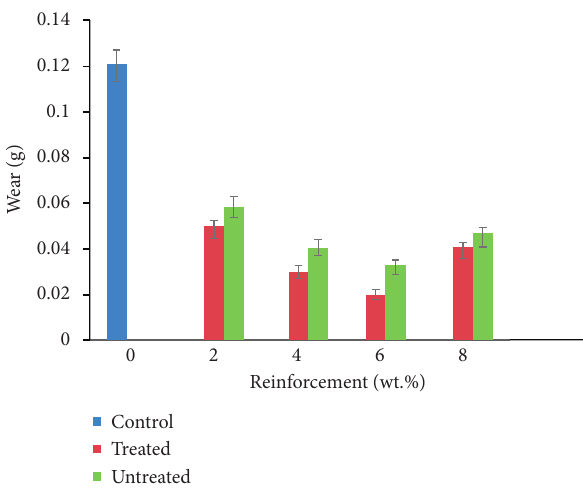
Figure 9: Variation in wear of coir fibre and yam peel particulate polyethylene